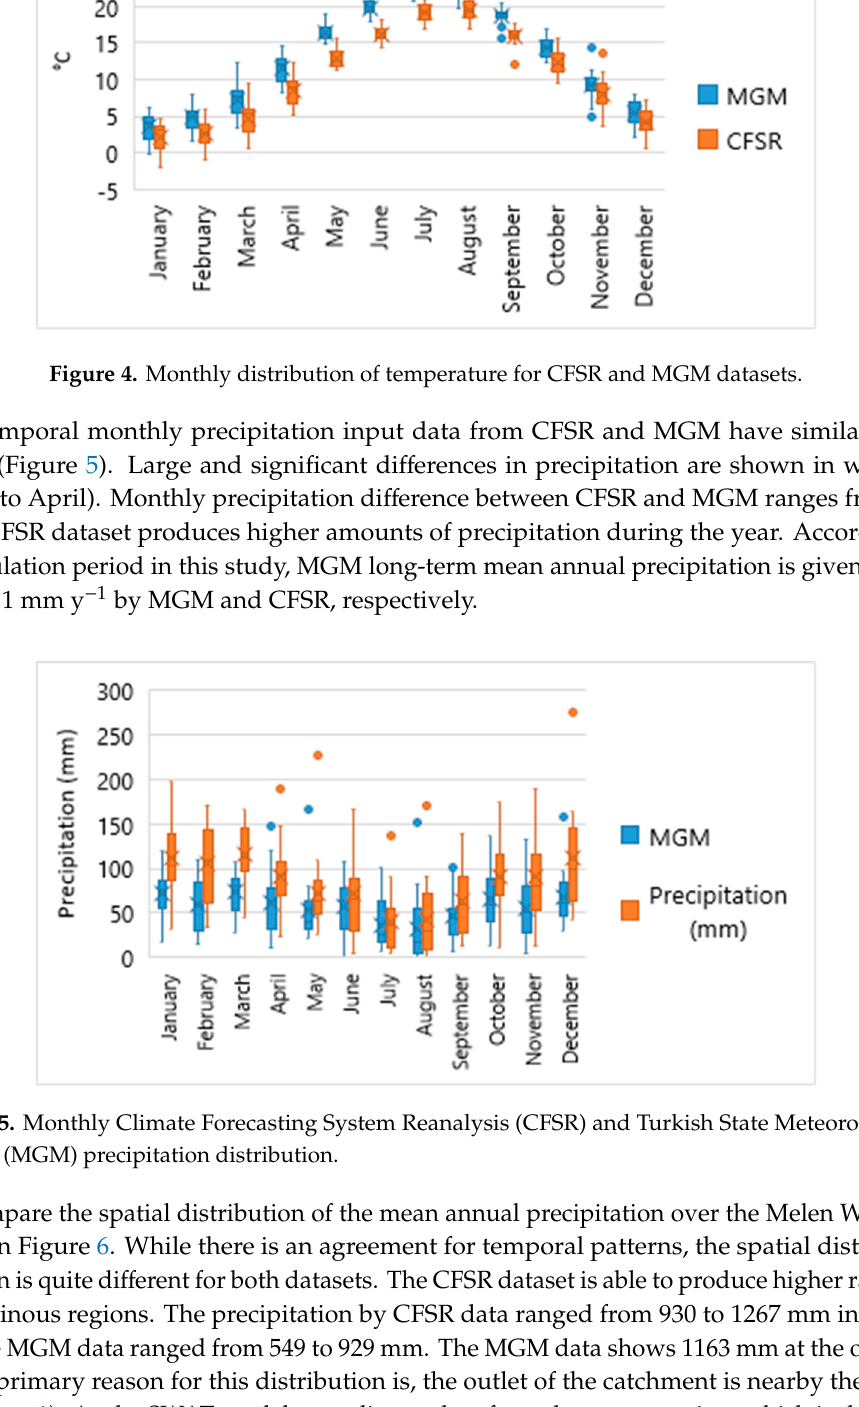
Figure 5. Monthly Climate Forecasting System Reanalysis (CFSR) and Turkish State Meteorological Service (MGM) precipitation distribution.